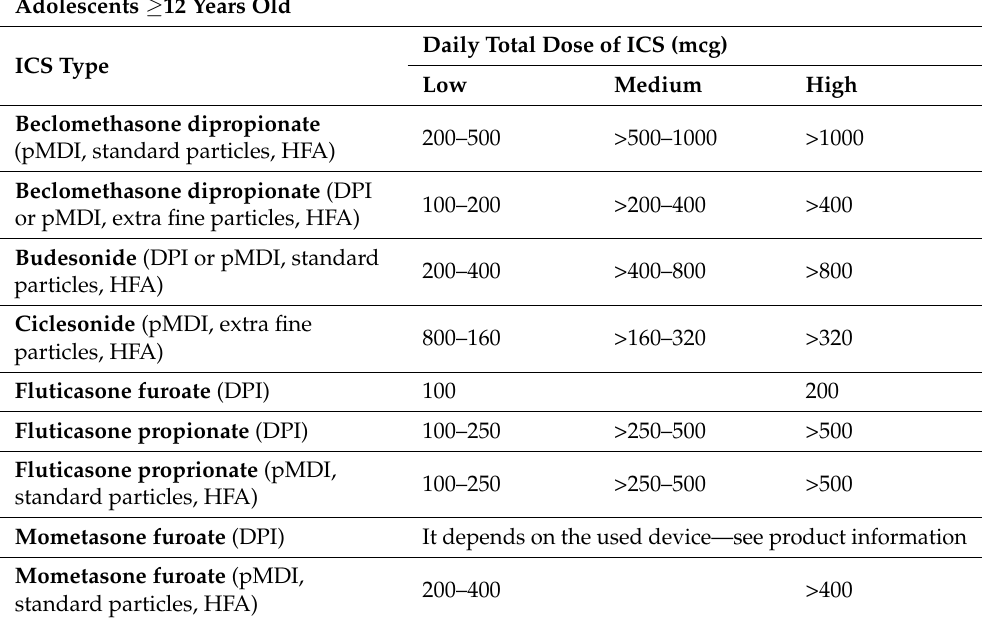
Table 3. Daily total dose of ICS recommended to adolescents aged ≥ 12 for asthma treatment based on GINA 2022 [6].